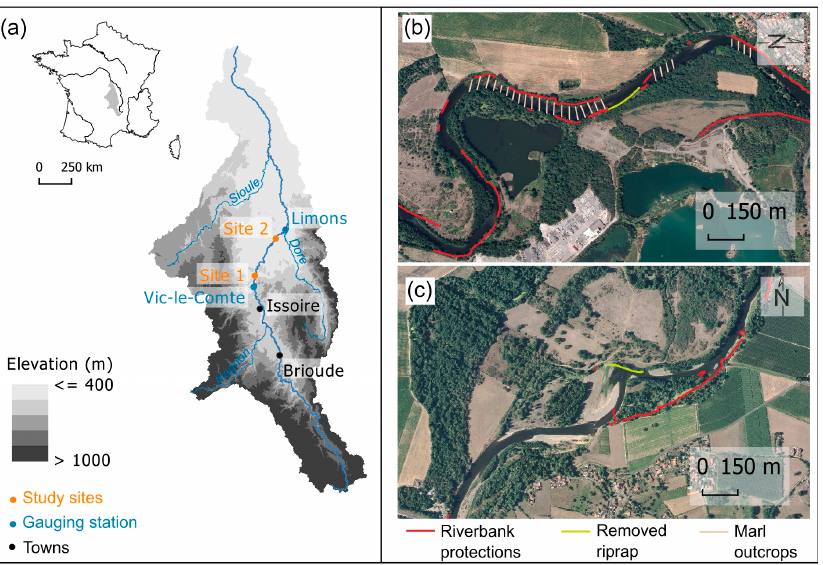
Figure 1. ( a ) Allier River catchment and location of the study sites and associated hydrological gauging stations. ( b ) Site 1. ( c ) Site 2. Map background: 2019 orthophotography produced by